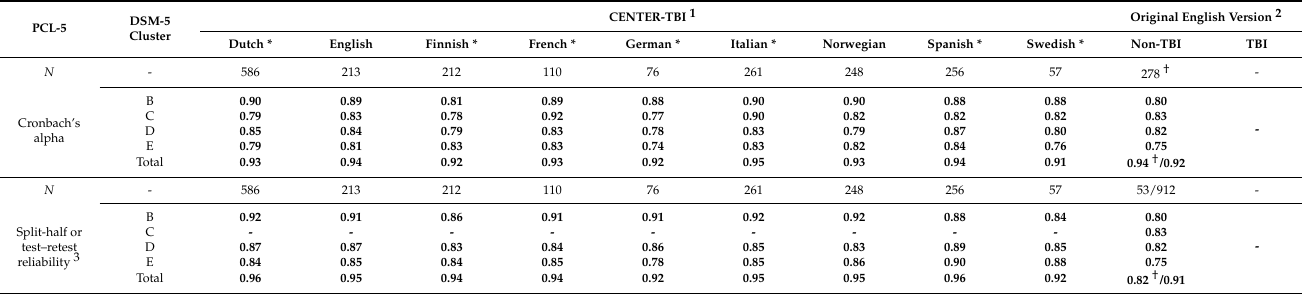
Table 3. Reliability of the PCL-5: Comparison of the CENTER-TBI results with the values from the original English validation